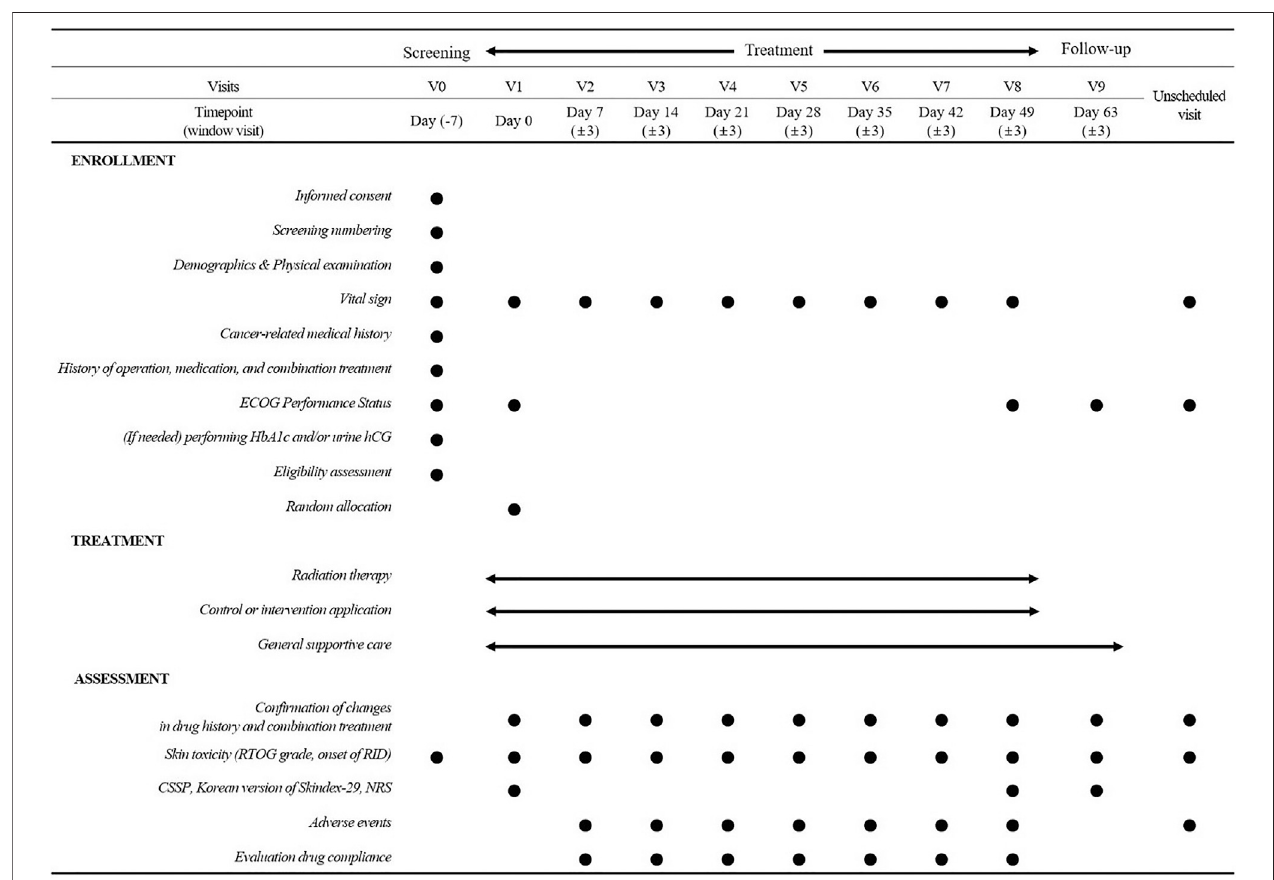
FIGURE 2 | Study procedures and outcome